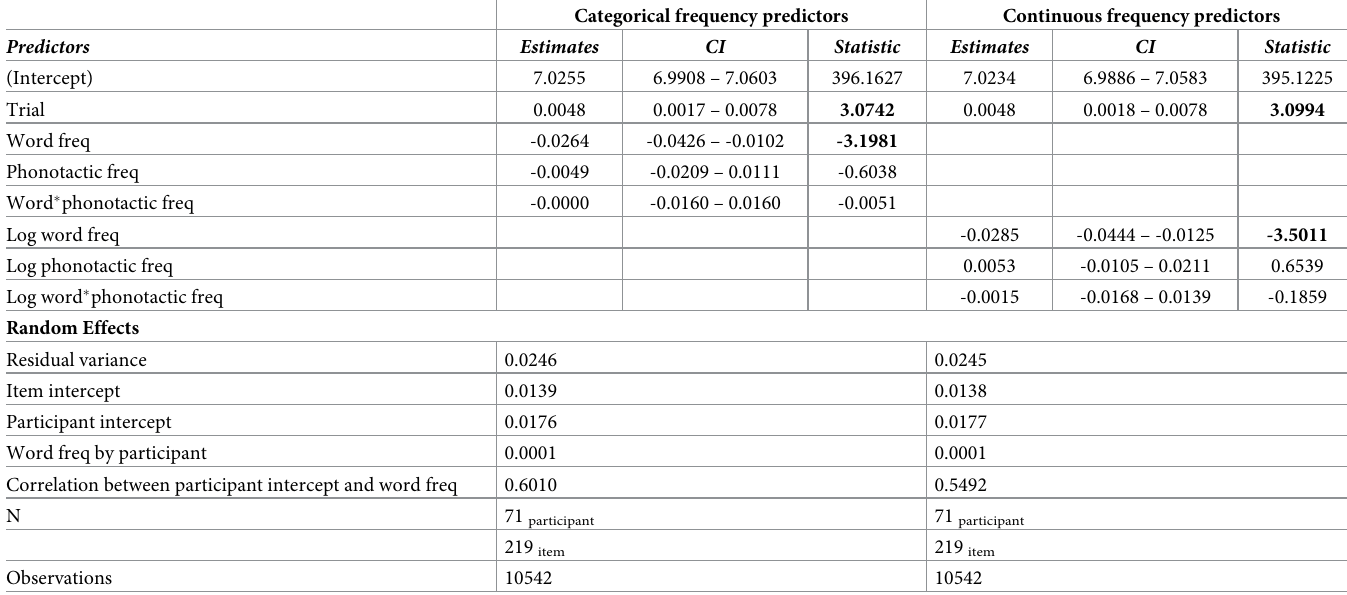
Table 1. Linear mixed model outputs of latency